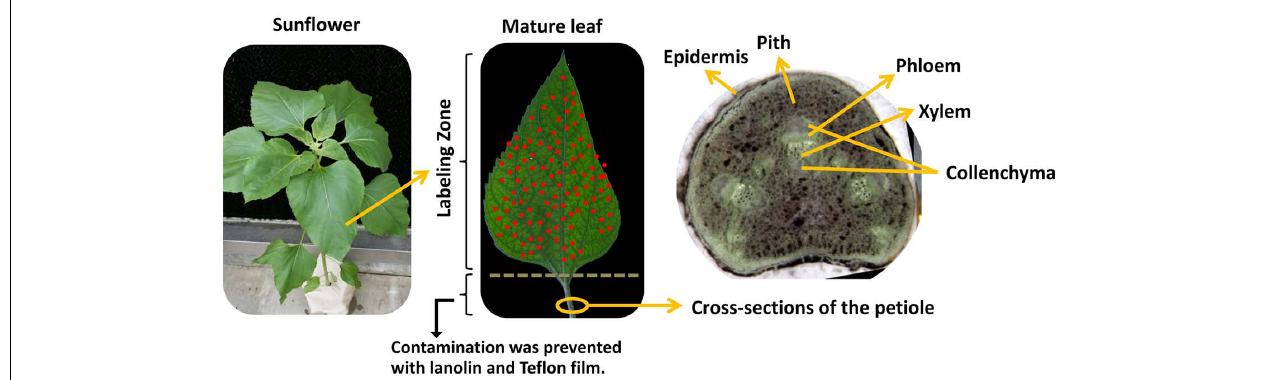
FIGURE 1 | Microscope image of petiole cross-section collected from sunflowers plants after foliar application. Fully expanded leaves of 1-month old sunflower were treated with different foliar fertilizers, then cross-sections of the petiole were cut by cryotome at − 20 ◦ C 7 days after final foliar fertilization treatment.